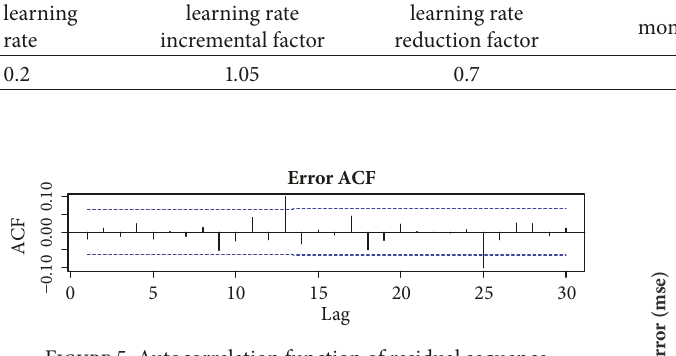
Figure 5: Autocorrelation function of residual sequence.